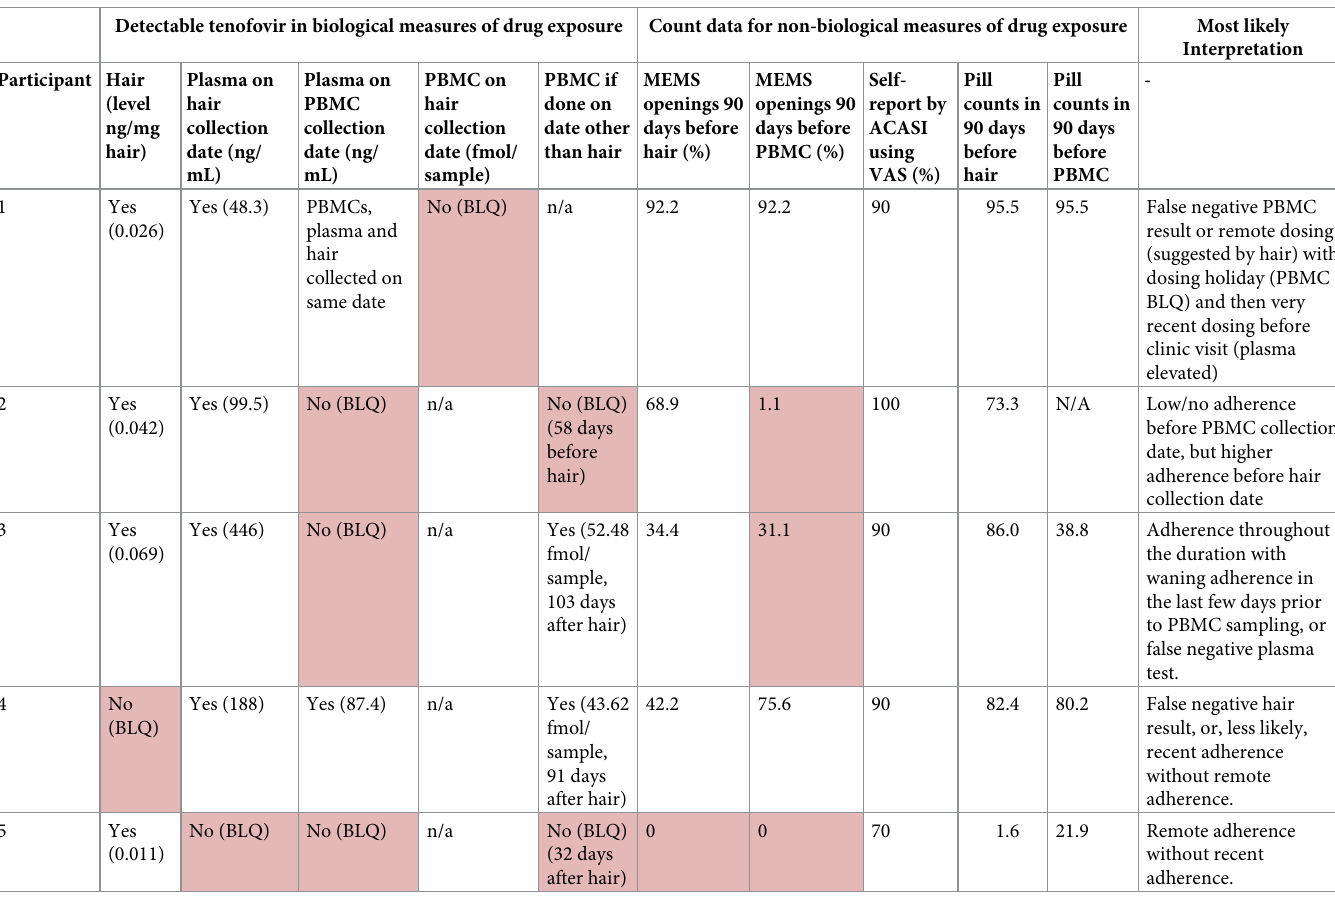
Table 4. Pharmacokinetic and non-pharmacokinetic adherence measures among five participants who had at least one sample with undetectable drug in the US CDC PrEP safety study. Detectable tenofovir in biological measures of drug exposure Count data for non-biological measures of drug exposure Most likely